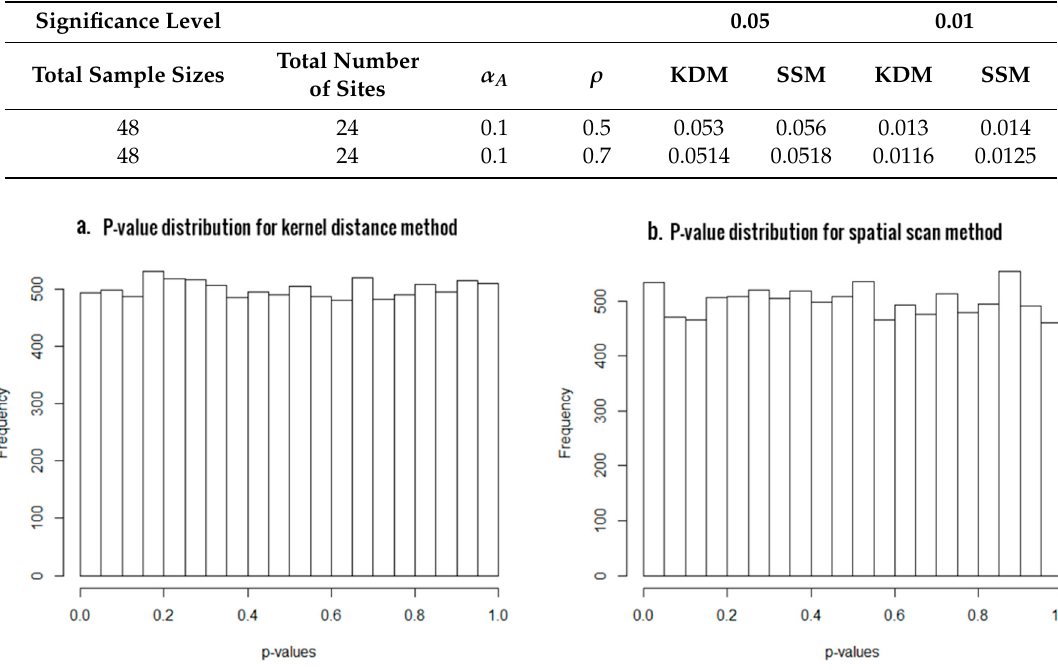
Figure 2. Power curves for SSM and KDM with 24 CpG sites at 𝛼 = 0.05 . rho ( ρ ) is the correlation of methylation rates between adjacent CpG sites.